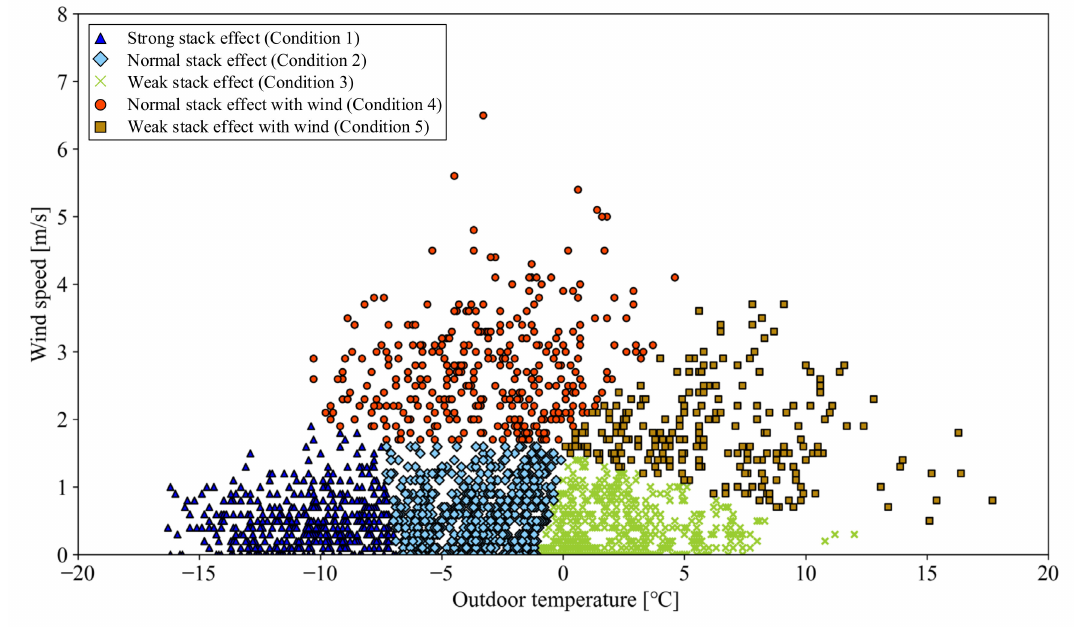
Figure 4. Five climatic conditions classified by k-means